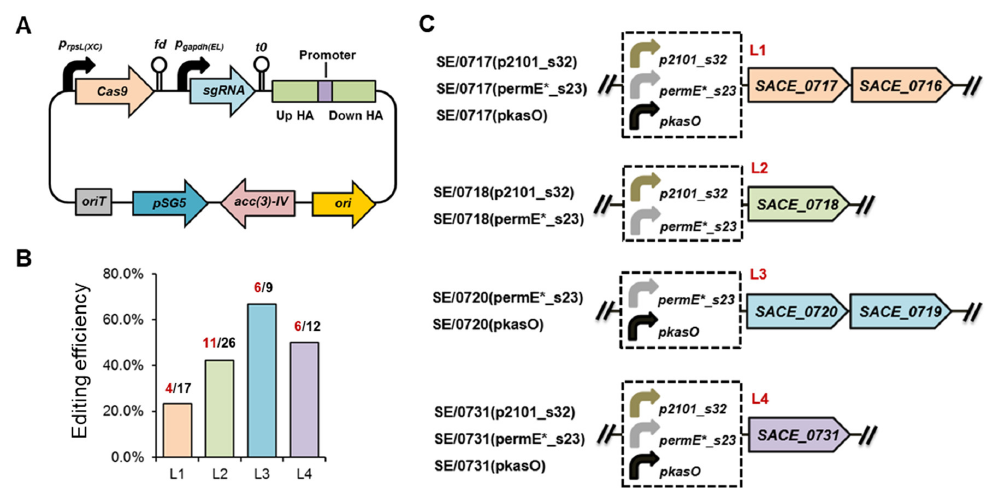
Figure 2. CRISPR/Cas9-mediated multi-locus promoter engineering in S. erythraea NRRL 23338. ( A ) Illustration of the CRISPR/Cas9 plasmid for genome editing. ( B ) CRISPR/Cas9 editing efficiencies at different loci. Numbers of correct colonies and verified colonies of each locus are shown in red and black, respectively. ( C ) Promoter engineering strategies at loci SACE_0717 (L1), SACE_0718 (L2), SACE_0720 (L3), and SACE_0731 (L4) and the names of the corresponding engineered strains.